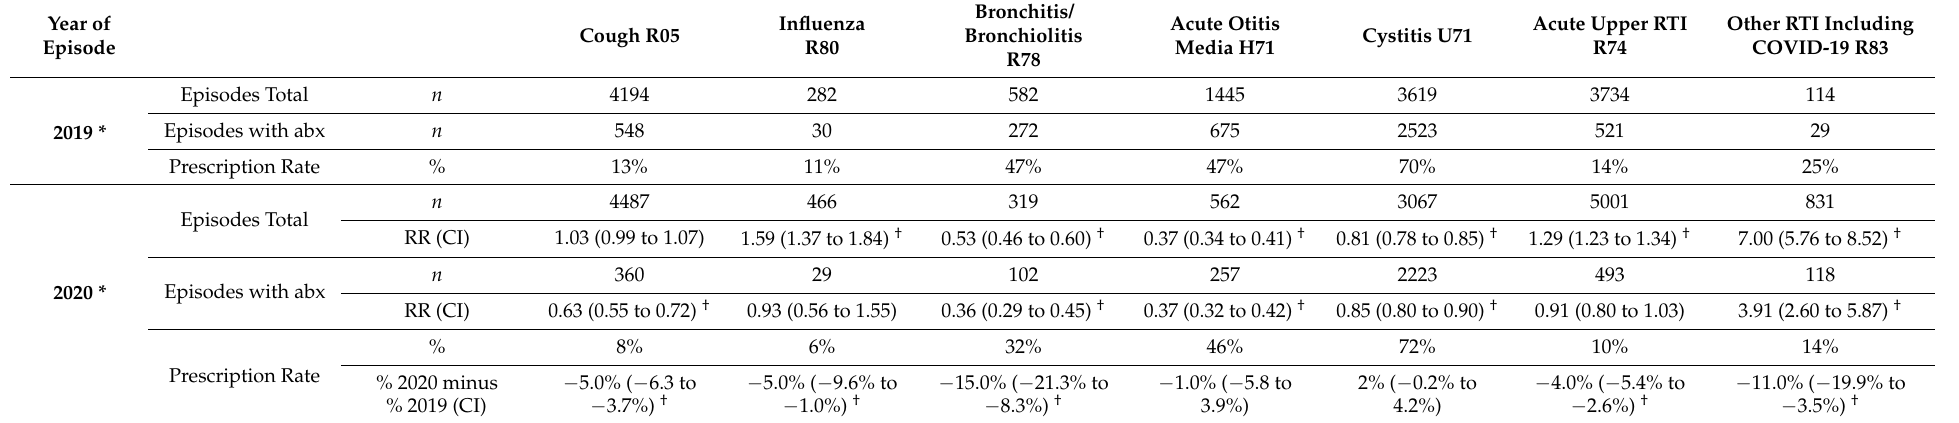
Table 3. Number of disease episodes and episodes with antibiotic prescription for respiratory tract/ear infections and cystitis episodes in 2019 and 2020 (March through May).